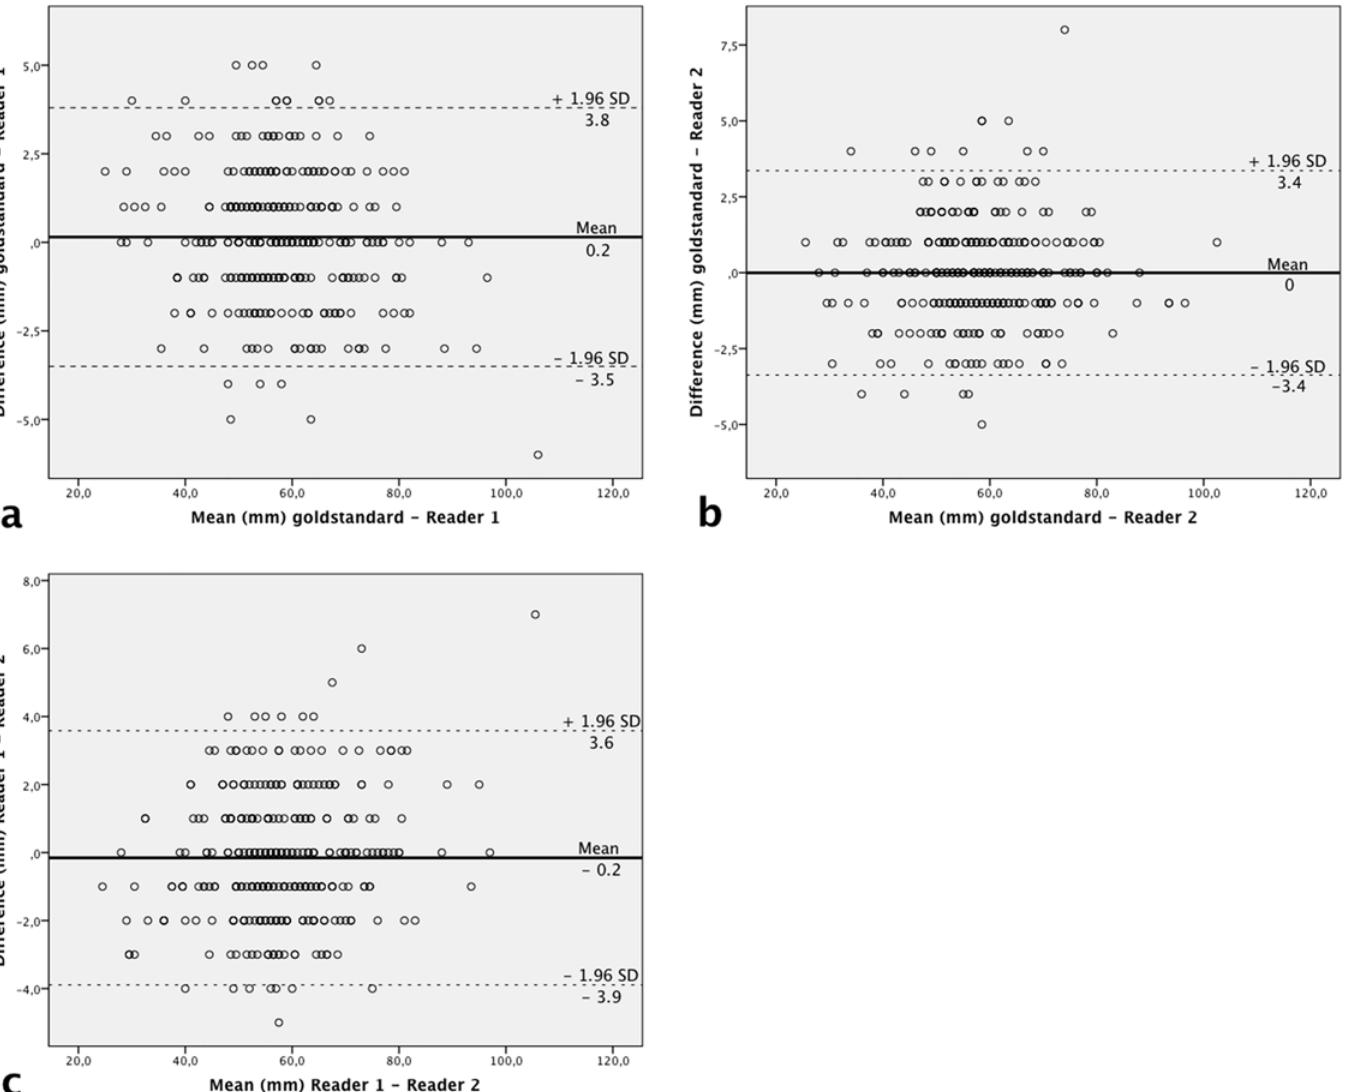
Fig 2. Scatterplots of diameter measurements of the aneurysm sac. Comparison of diameter measurements of the aneurysm sac (n = 334) between (a) gold standard and reader 1, (b) gold standard and reader 2, and (c) reader 1 and reader 2. The solid line denotes the mean of the differences (md) between compared groups. Dashed lines indicate the upper and lower limits of the agreement region (md ± [1.96 x SD]), where SD is the standard deviation of differences. mm = millimeter.